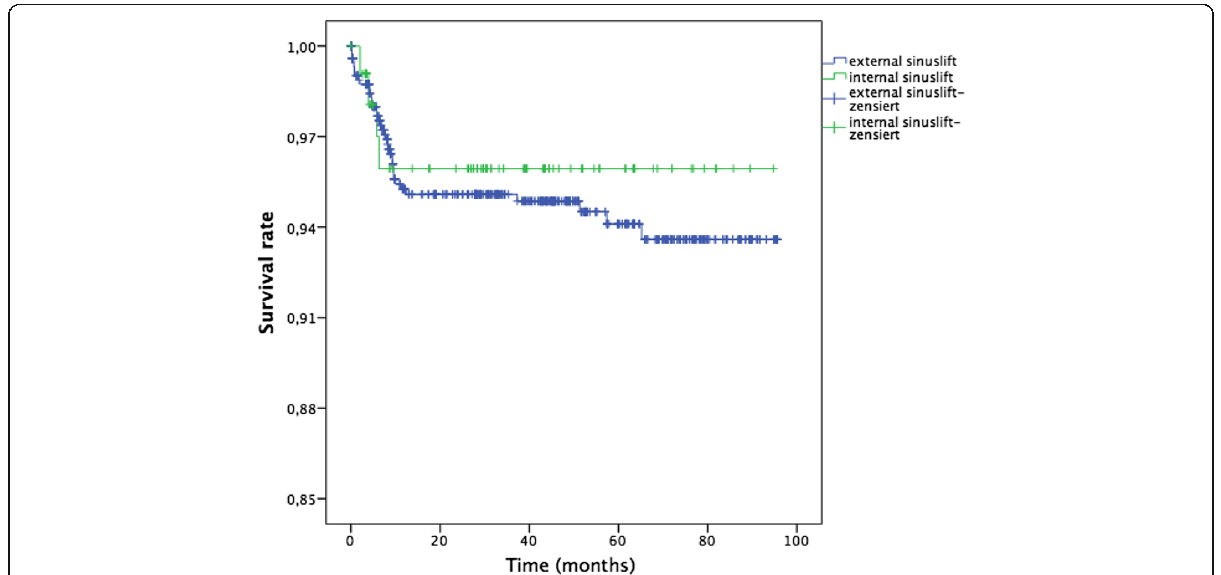
Fig. 2 Cumulative survival rate according to Kaplan – Meier and sinus augmentation